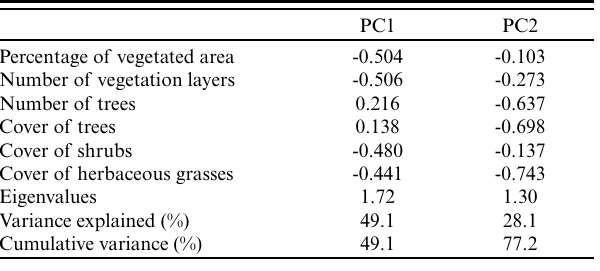
Table 2 . Results of the principal components analysis of vegetation variables in rural settlements in the Huaibei coal mining area in the North China Plain. PC = principal components.